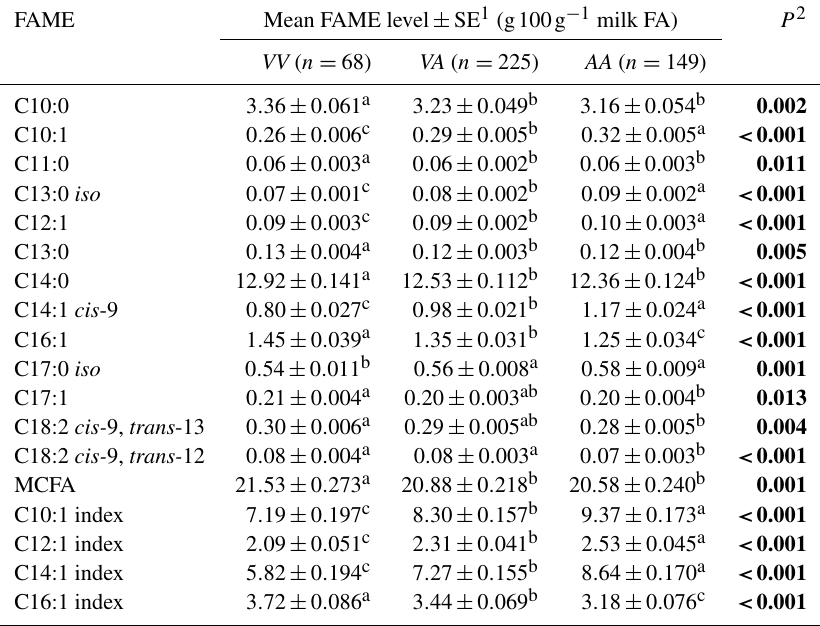
Table 2. Association between milk fatty acid levels and p.A293V genotypes.